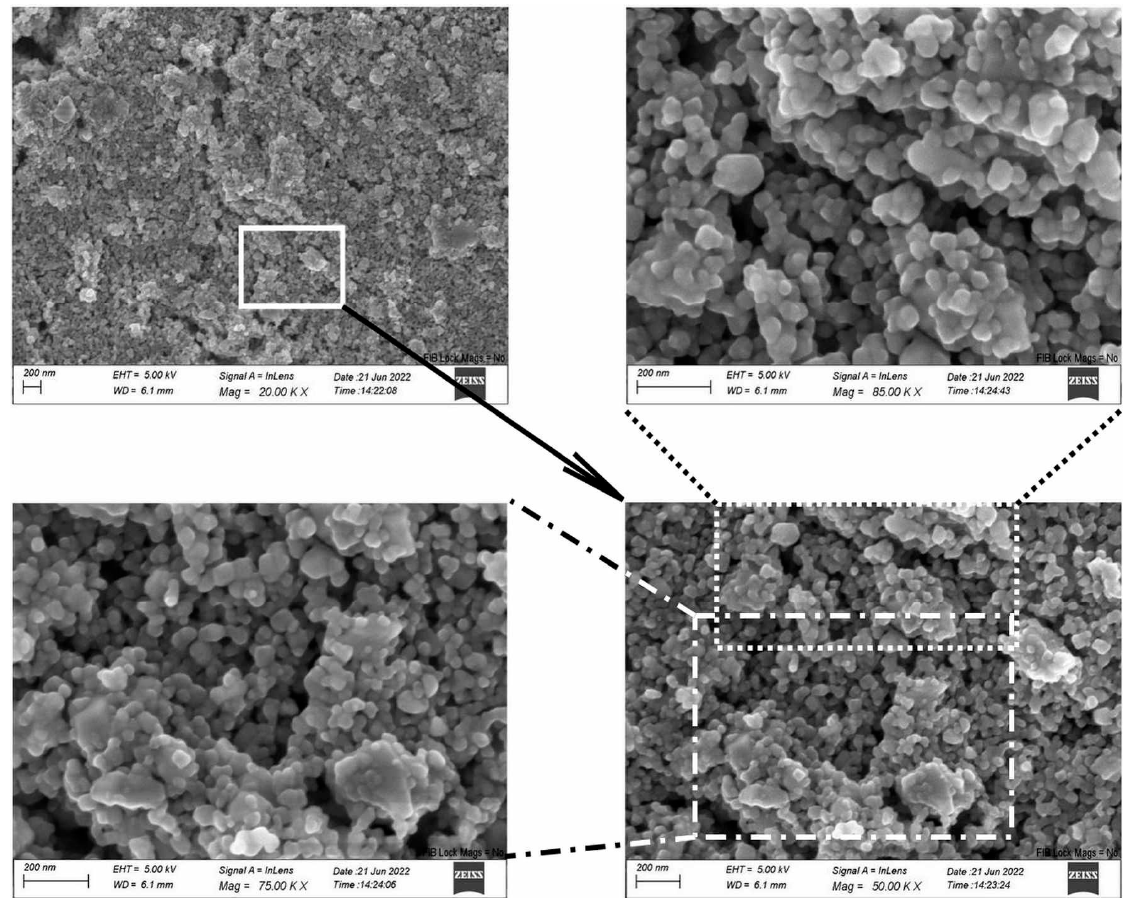
Figure 7. SEM image of the TiCe-0.5:0.5-40 sample at the center of the paste region.